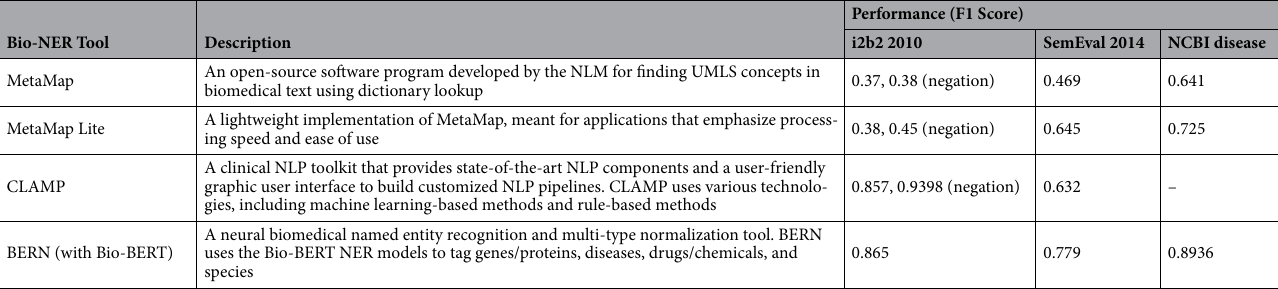
Table 2. Bio-NER tools used in the study. MetaMap, MetaMap Lite and CLAMP provide configurable assertion detection (i.e., negation), hence the two performance values in the i2b2 2010